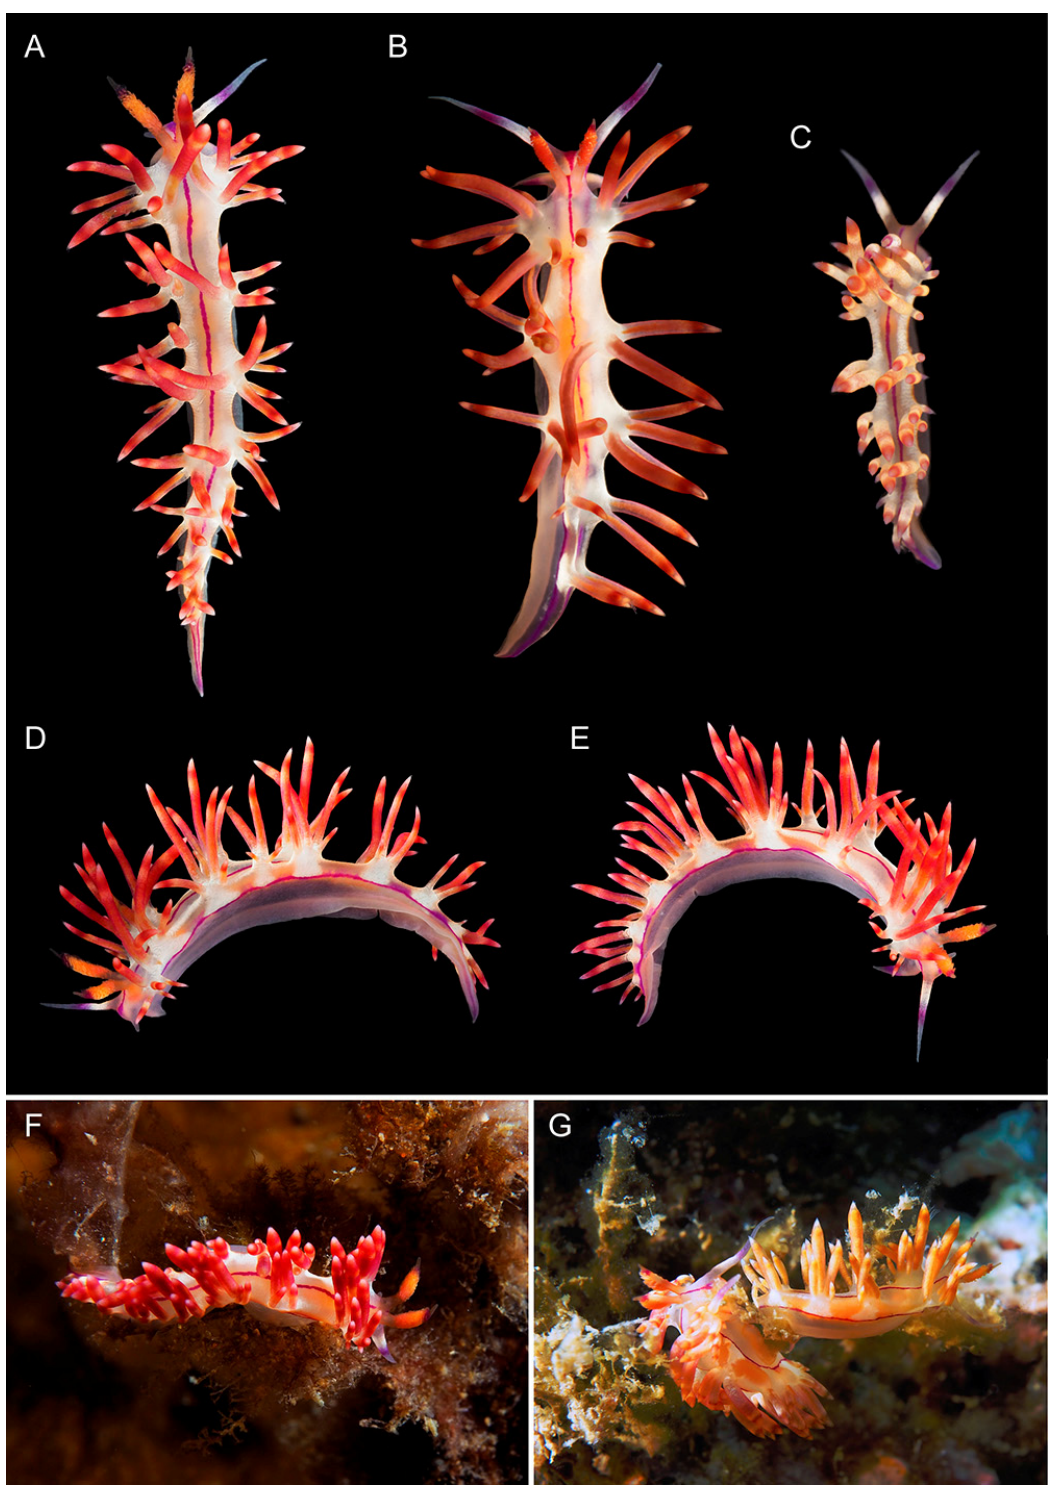
Figure 10. Coryphellina flamma sp. nov., external morphology. ( A )—holotype ZIN63218, specimen 12 mm in length (preserved), dorsal view. ( B )—paratype ZIN63219, specimen 10 mm in length (preserved). ( C )—paratype ZIN63222, specimen 7 mm in length (preserved). ( D )—holotype ZIN63218, lateral view from left. ( E )—holotype ZIN63218, lateral view from right. ( F )—holotype ZIN63218 in natural environment. ( G )—paratypes ZIN63220, ZIN63221 in natural environment. Photo credits: ( A , D – G ): Yury Deart; ( B , C ): Elena Mekhova.